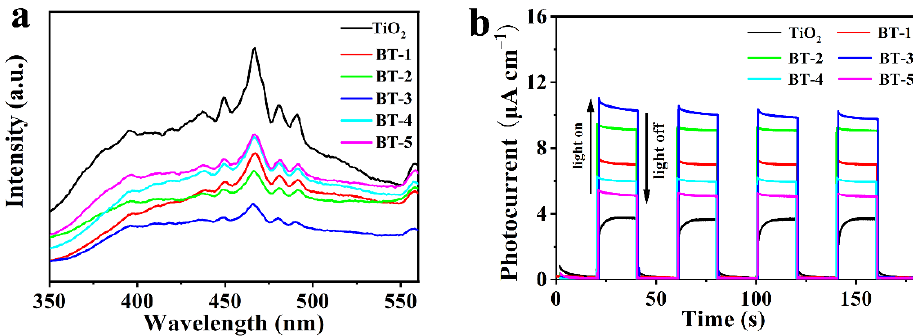
Figure 5. ( a ) PL spectra of as-synthesized samples; ( b ) photocurrent of as-prepared photoanodes.